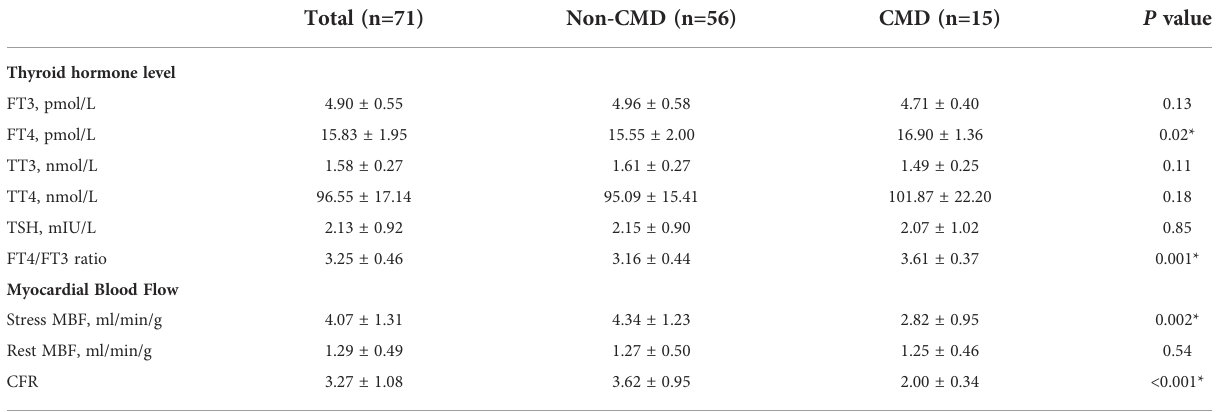
TABLE 2 Thyroid hormone level and CFR of the study population.